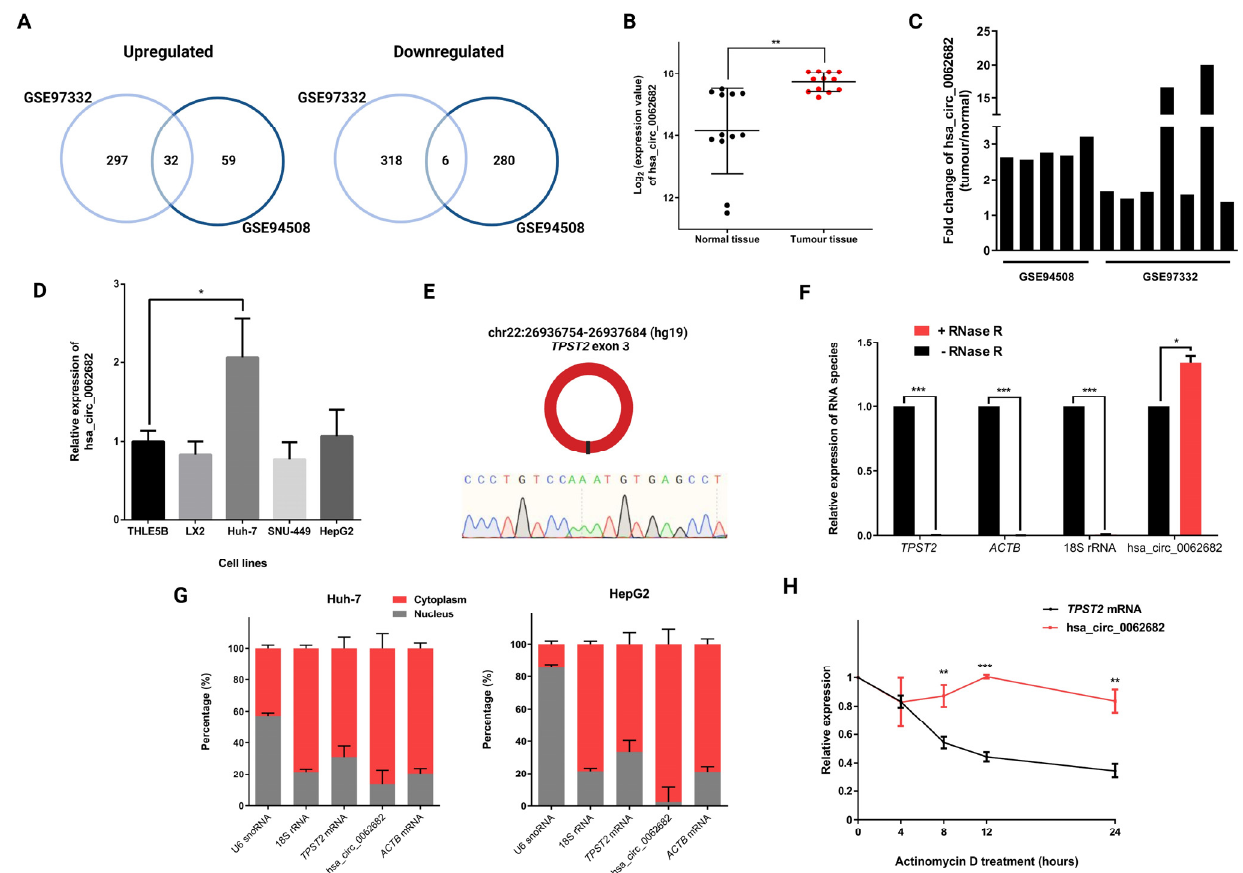
Figure 1. Hsa_circ_0062682 is upregulated in HCC and is predominantly localized in the cytoplasm. ( A ) Venn diagrams showing differentially expressed circRNAs found in two studies (GSE94508, GSE97332) (fold change (FC) ≥ 1.5 or ≤− 1.5; adjusted p -value ≤ 0.05); ( B ) log 2 of hsa_circ_0062682 expression in normal tissues and tumour tissues in both studies; ( C ) fold change in hsa_circ_0062682 expression in paired tumour tissue vs. normal tissue in patients of aforementioned studies; ( D ) relative expression of hsa_circ_0062682 in liver model cell lines, normalized to the geomet- ric mean of ACTB / RPLP0 expression (n = 3); ( E ) schematic representation of a single exon circRNA hsa_circ_0062682 and its backsplice sequence; ( F ) relative expression of RNA species after treating 1 µ g of Huh-7 total RNA with RNase R (n = 3); ( G ) localization of hsa_circ_0062682 and other RNA species in Huh-7 (left) (n = 3) and HepG2 (right) cell lines (n = 3); U6 snoRNA served as a positive control for the nuclear fraction and 18S rRNA served as a positive control for the cytoplasmic fraction; ( H ) relative expression of hsa_circ_0062682 and TPST2 mRNA after treatment of Huh-7 cell line with actinomycin D (n = 3). results are represented as averages and error bars represent standard deviation. * p -value ≤ 0.05; ** p -value ≤ 0.01; *** p -value ≤ 0.001; Student’s t